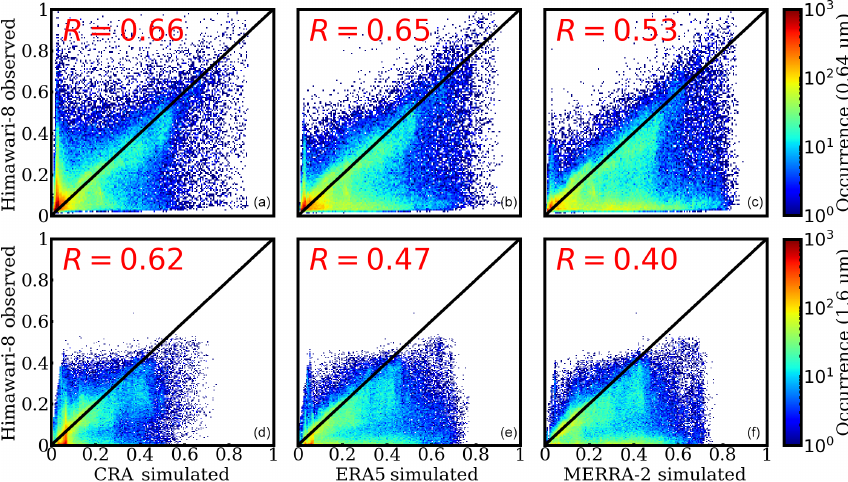
Figure 2. Pixel-to-pixel comparisons between the observed and simulated reflectance in the 0.64µm (a, b, c) and 1.6µm (d, e, f) channels. The histograms illustrate the occurrences of reflectance, and the results are taken at the same time as that in Fig.